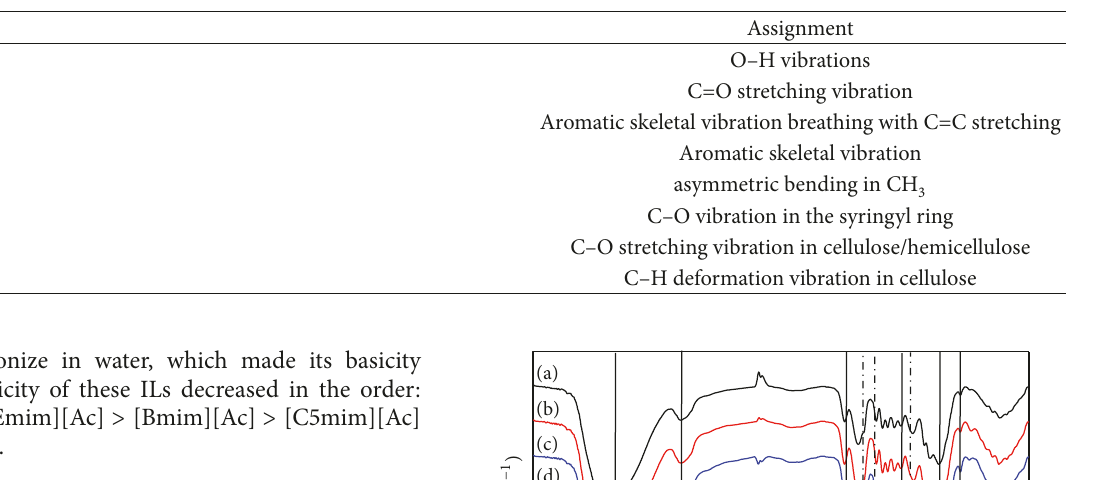
Table 3: Band assignments for FTIR spectra.